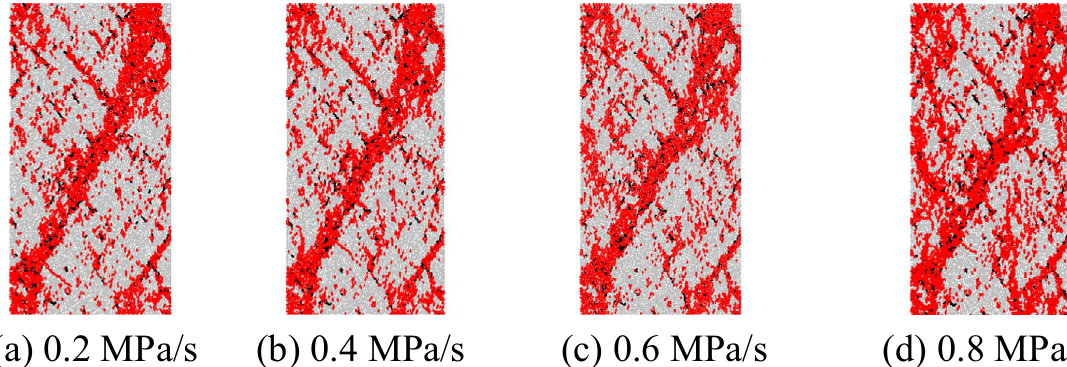
Figure 9. Distribution of mesoscopic cracks during failure of the marble at different unloading proportion of tension cracks grows from 90.63 to 92.69%, while that of shear cracks decreases from 9.37 to 7.31%, suggesting that the high unloading rate is more likely to generate tension cracks. Failure modes. Figure 9 shows the distribution of mesoscopic cracks in the marble during failure at differ- ent unloading rates of the confining pressure, where red and black represent tension cracks and shear cracks, respectively. The rock is dominated by shear failure and the dominant shear planes are surrounded by second- ary cracks. There is a small number of secondary cracks at a low unloading rate of 0.2 MPa/s. As the unloading rate is increased, the secondary cracks become more numerous and coalesce to form secondary failure planes. The higher the unloading rate, the larger the amount of secondary failure planes. This is because the effect of confining pressure on the sample is gradually diminished due to confining-pressure unloading. The faster the confining-pressure unloading, the more rapid the decrease of confining pressure and the faster the transverse motion of particles. As a result, the tendency of cracks to propagate along the dominant shear planes reduces and secondary cracks are more apt to extend transversely. Influence of the initial unloading stress. Number of cracks. Figure 10 shows the crack number-strain curves of the marble during failure with different initial unloading stresses. The initial unloading stresses are 60%, 70%, 80%, and 90% of the peak strength pre-peak, and the unloading process is ended when the axial stress reaches 60% thereof post-peak. The stress–strain curves are similar, with an initial slow, then rapid increasing trend. The closer the initial unloading stress to the peak strength, the longer the slow increase process of the curve in the initial stage of deformation and the later the abrupt growth of the crack number in the late stage. The rate of growth of cracks at a high unloading rate is greater than that at a low unloading rate. This indicates that, at the same initial unloading stress, the high unloading rate exerts a greater effect on crack propagation. Failure modes. The failure modes of the marble at different initial unloading stresses and an unloading rate of 0.2 MPa/s are shown in Fig. 11. The axial stress is kept unchanged as the confining pressure is varied between 60 and 90% of the peak strength pre-peak. The failure mode of the marble does not change when increasing the initial unloading stress of the confining pressure, while the number of cracks increases significantly. Influence of the confining pressure. Number of cracks. The overall shape of the crack number-strain curves during failure of the marble under different confining pressures is similar (Fig. 12). As the confining pres- sure is increased from 5 to 40 MPa, the number of cracks grows slowly in the initial stage of deformation, while increasing abruptly in the later stages thereof. The larger the confining pressure, the longer the period of slow increase in deformation, indicating that a high confining pressure can inhibit crack propagation in the initial stages of testing. Figure 13 illustrates the crack number-confining pressure relationships during failure of the marble under confining-pressure unloading. As shown, the confining pressure, total number of cracks, number of tension cracks, and number of shear cracks all exhibit an increasing trend, while the rates of growth of the total number of cracks and the number of tension cracks decrease, and the rate of growth of the number of shear cracks remains unchanged. This suggests that, as the confining pressure is increased, the proportion of shear cracks among all cracks increases while that of the tension cracks falls. At a confining pressure of 5 MPa, there are 163 shear cracks, which account for 5.6% of the total, and 1747 tension cracks (94.4% of the total); while at a confining pressure of 50 MPa, there are 812 shear cracks and 4050 tension cracks, 16.7% and 83.3% of the total. Failure modes. The failure modes of the marble under unloading from different confining pressures are dis- played in Fig. 14. Shear-dominated failure is found at low confining pressures; as the confining pressure is increased, the amount of secondary failure planes increases around the dominant shear planes, showing a tran- sition from shear-dominated failure to conjugated shear failure.